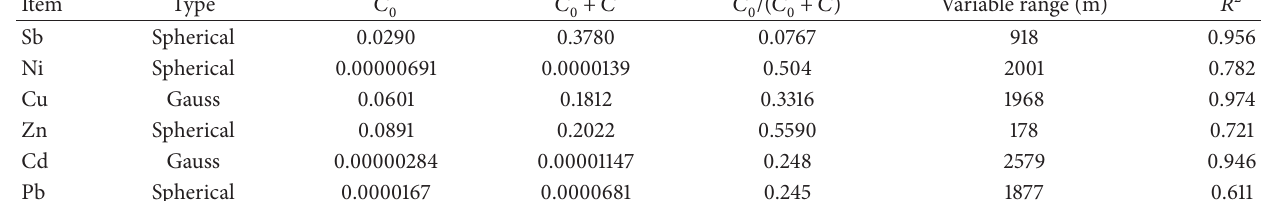
Table 3: Theoretical semivariation function model and parameter of Sb, Ni, Cu, Zn, Cd, and Pb content of in surface runoff in the antimony mine.